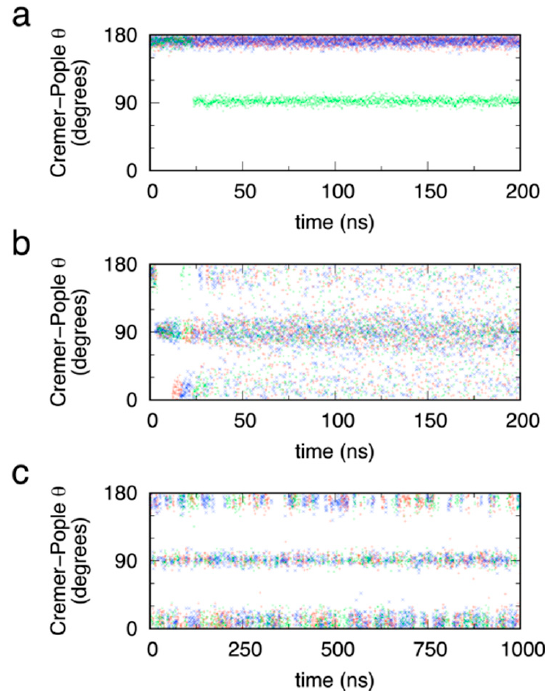
Figure 5. Me α IdoA conformational transitions in standard (non-biased) ( a ), eABF ( b ), and CMAP- biased ( c ) molecular dynamics simulations. eABF and CMAP biased simulations have biasing on the Babin-Sagui ( α 1 , α 2 ) reaction coordinate. Data in each panel are from triplicate simulations (blue, red, and green) seeded with different random initial